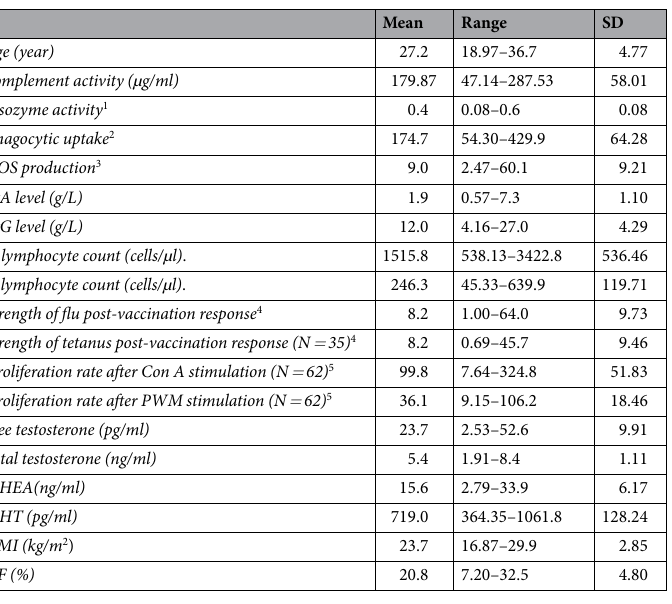
Table 1. Descriptive statistics for the analyzed parameters (N = 97). 1 The difference in absorbance value between control samples (bacteria suspension without lysozyme) and test samples (bacteria treated with serum- contained lysozymes). 2 Mean fluorescence intensity of blood phagocytes after phagocytosis of fluorescently labeled bacteria. 3 Mean area under the chemiluminescence curve (AUC CL ) for stimulated test sample divided by AUC CL for control. 4 Fold increase in antibody titers (for influenza) or antibody levels (for tetanus) before and after vaccination. 5 Stimulation index − (CPM for stimulated test sample divided by CPM for unstimulated